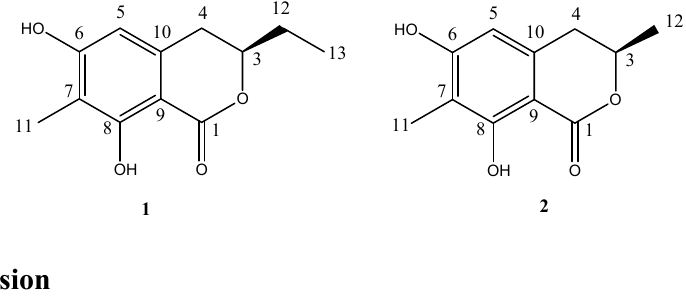
Figure 1. Structures of new attractants from Eupolyphaga sinensis Walker.